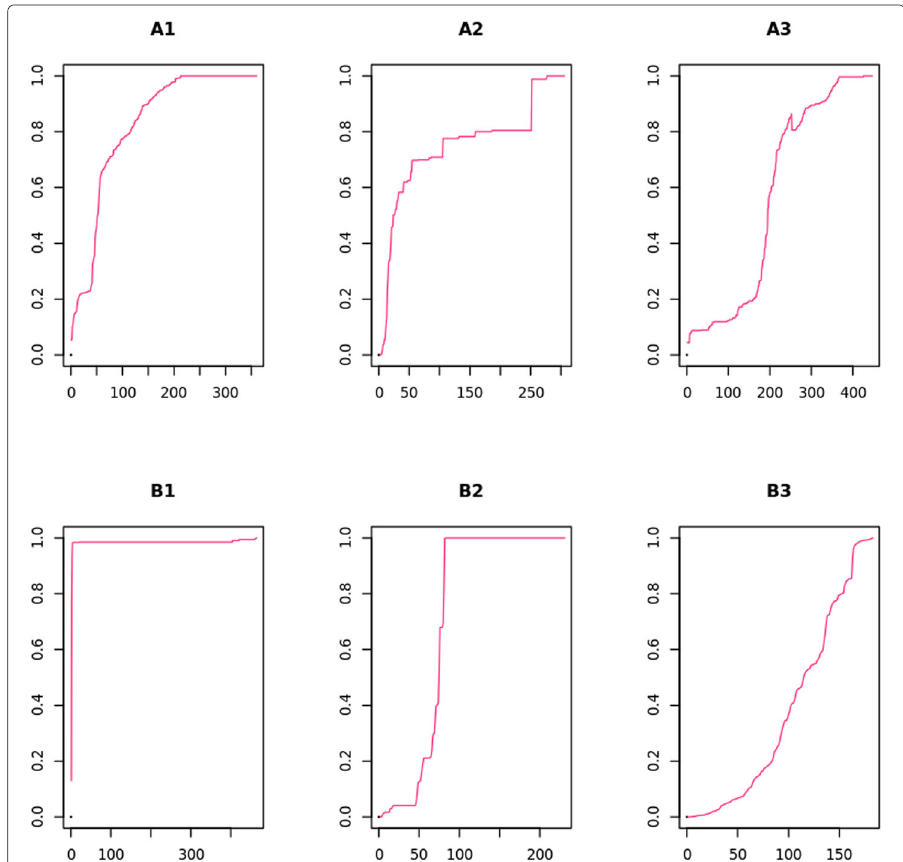
Fig. 8 Standard Deviation of Amount in Play over Time